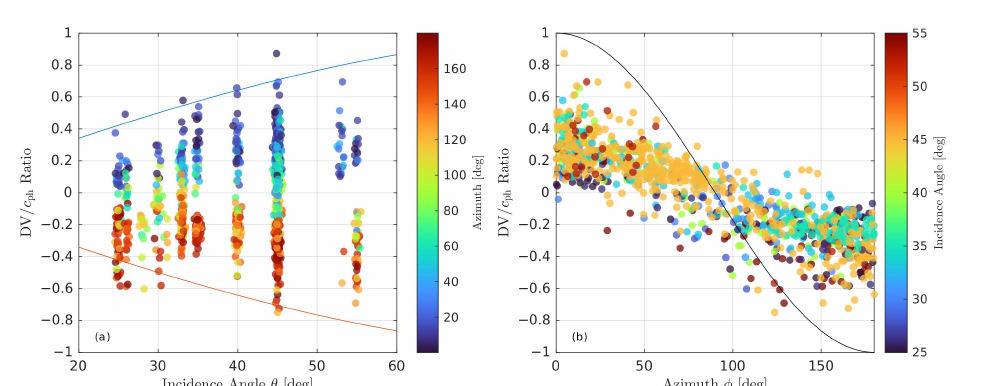
Figure 6. The Doppler velocity (DV) normalized by the phase velocity of the breaking wave, DV/ c ph , at VV polarization versus ( a ) the incidence angle, θ , for different color-coded breaker azimuths, φ , and ( b ) breaker azimuths, φ , for different color-coded incidence angles, θ . The lines indicate limiting normalized speeds: ( a ) ± sin θ and ( b ) cos φ